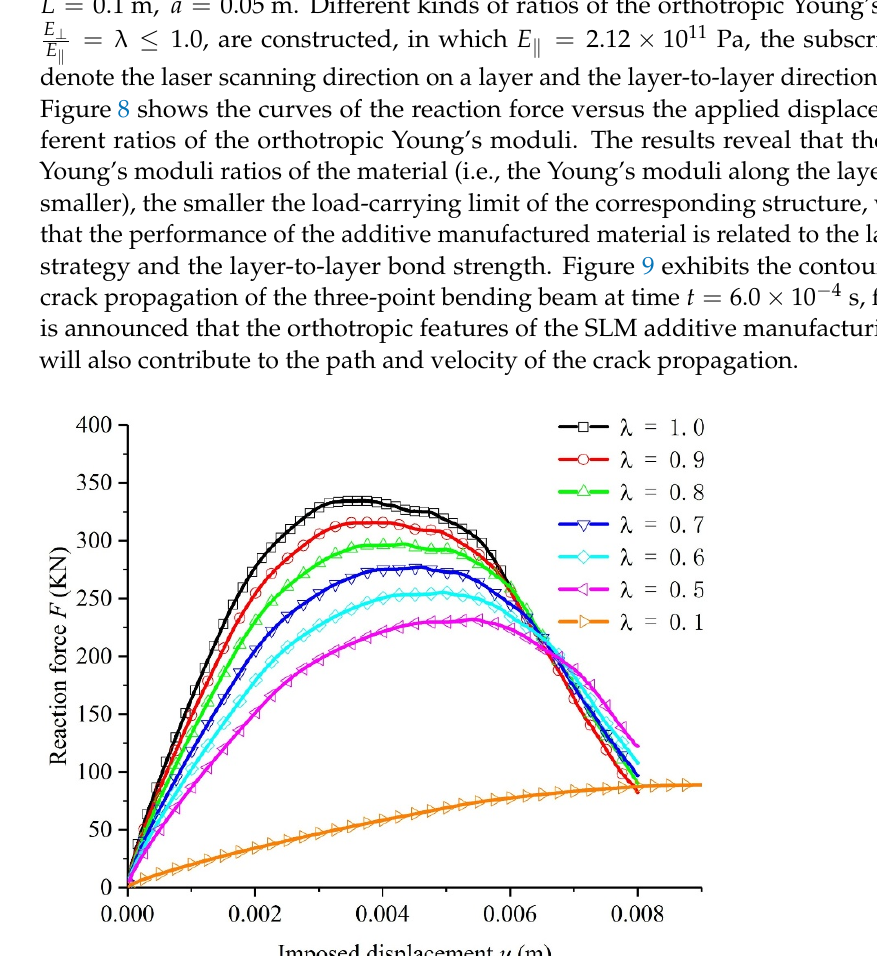
Figure 7. Crack patterns for these four loading cases at time 𝑡 = 3.0 × 10 (cid:2879)(cid:2872) s and 𝑡 = 6.0 × 10 (cid:2879)(cid:2872) s .